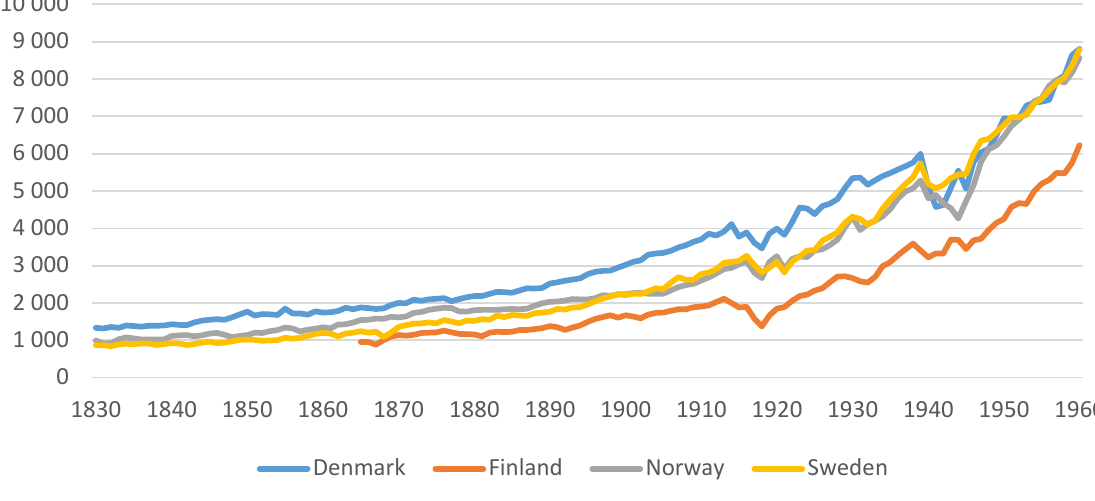
Figure 1. GDP per capita in the Scandinavian countries in 2002,